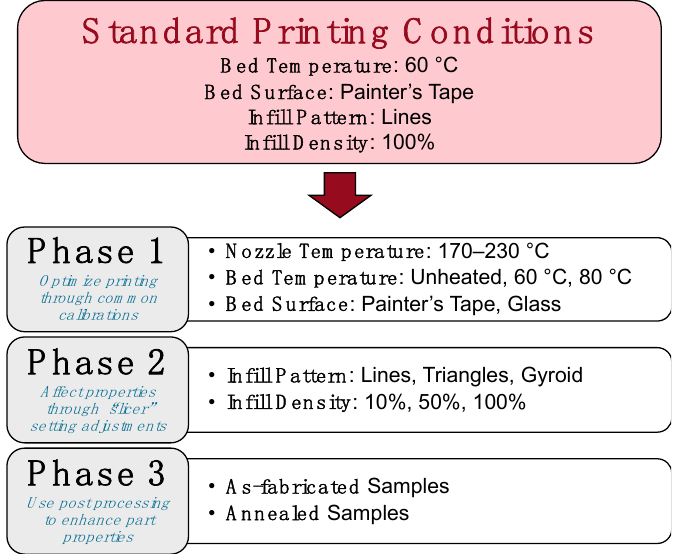
Figure 1. Three-phase experimental setup to demonstrate processing parameter optimization for PLA in FFF.